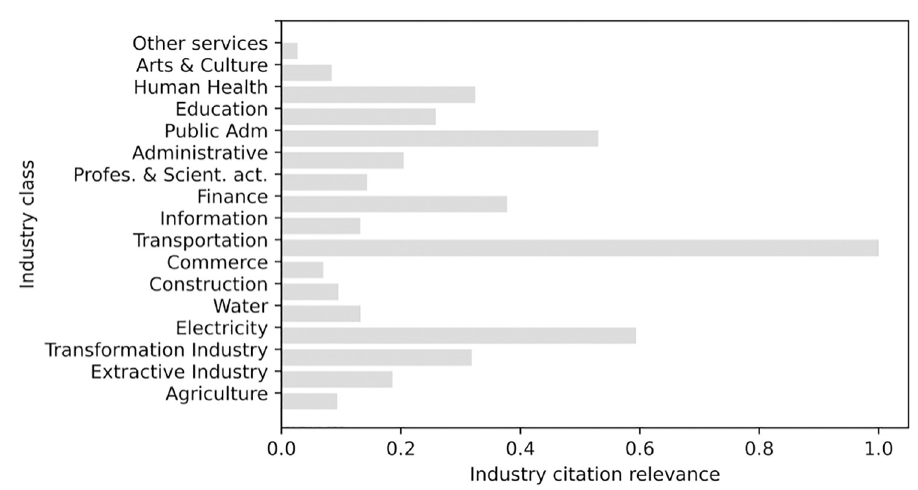
Fig 7. Industry citation relevance metric for the year of